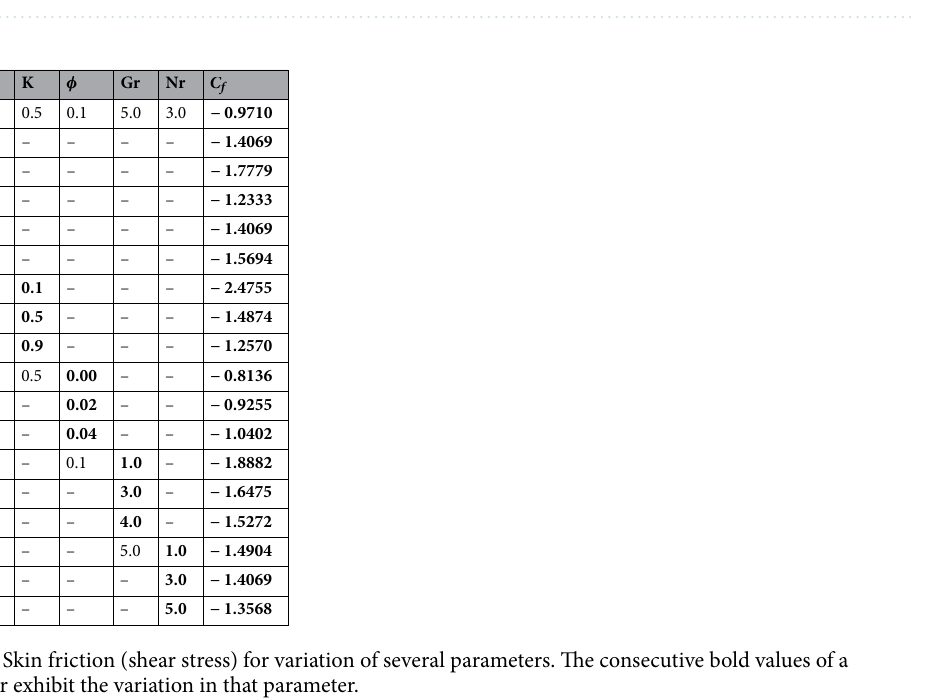
Figure 15. Comparison of skin friction [Eq. (43)] for different nanofluids when M = 2.0 , K = 0.5 , Gr = 5.0 , Nr = 0.5 and Q = 0.5 .